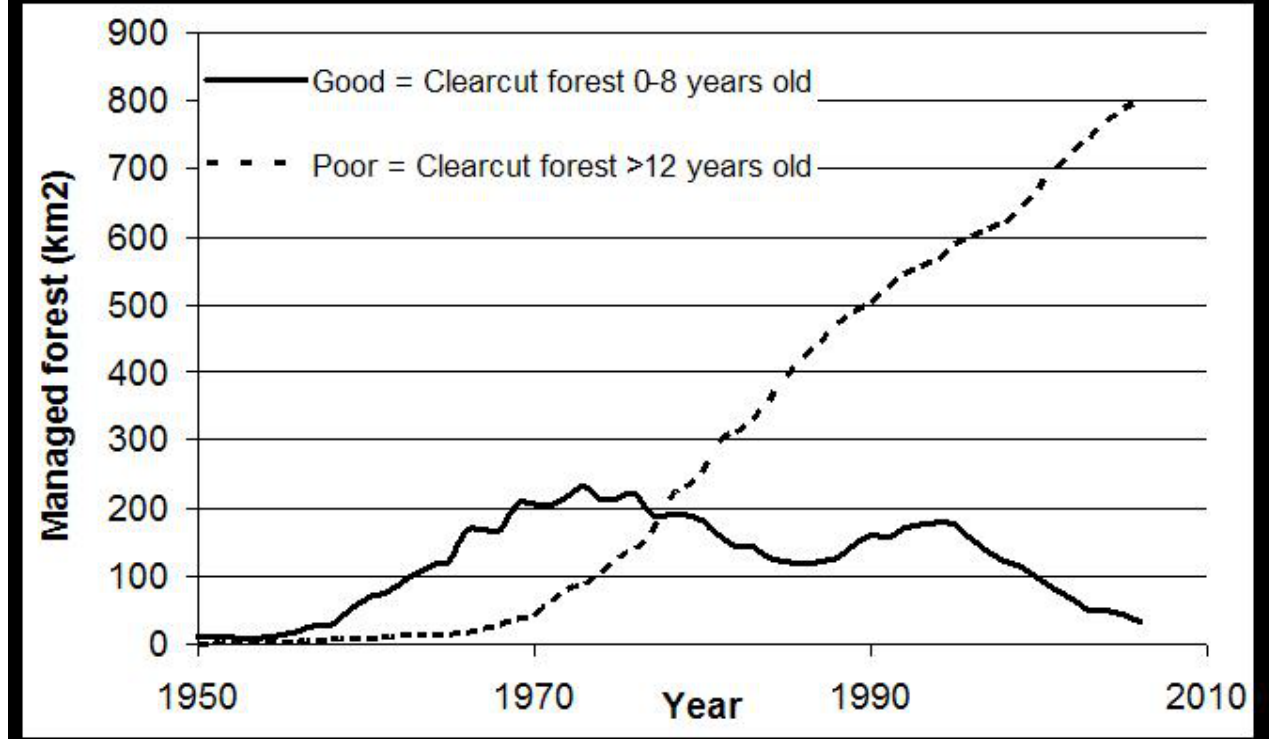
Fig. 4 . Change in areas (km²) of managed forest considered “good” and “poor” habitat for deer hunting based on responses from deer hunters interviewed on Prince of Wales Island,